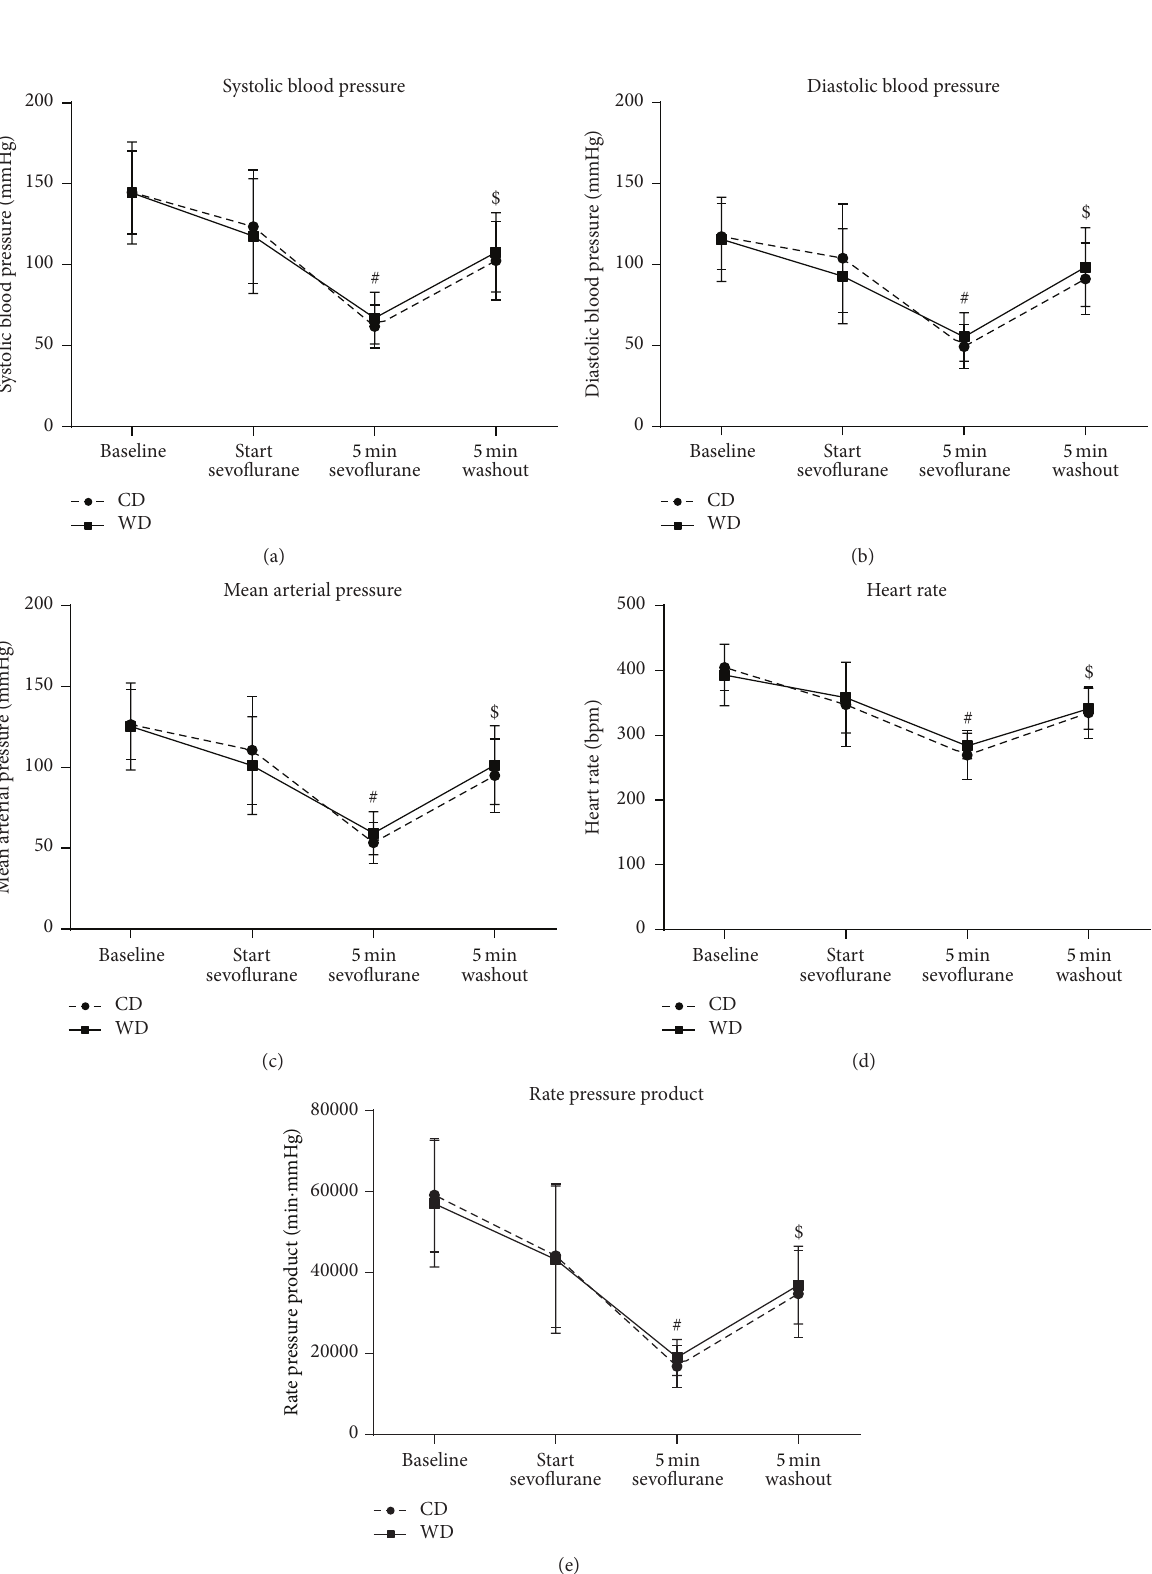
Figure 4: Hemodynamics during sevoflurane exposure. Systolic blood pressure (a), diastolic blood pressure (b), mean arterial pressure (c), heart rate (d), and rate pressure product (e) during baseline conditions, before sevoflurane exposure, after 5 minutes of sevoflurane and after 5 minutes of washout period in rats fed a control diet (CD) or western diet (WD) for 8 weeks. Data are mean ± SD, 𝑛 = 16 – 18 , two-way ANOVA with repeated measurements, and Bonferroni post hoc analyses, # 𝑝 < 0.05 sevoflurane effect, $ 𝑝 < 0.05 washout